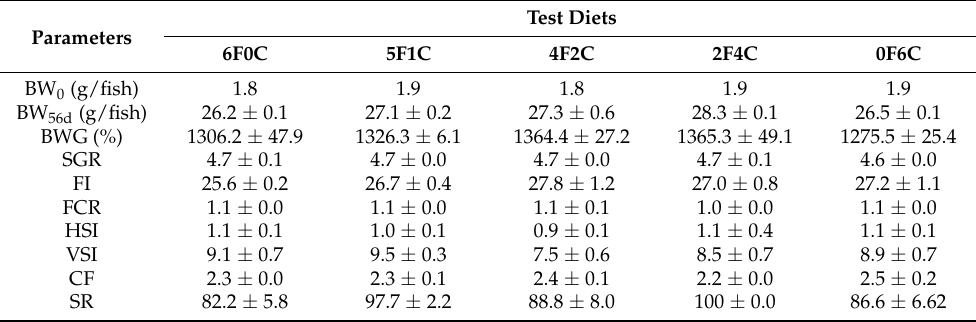
Table 3. Performance variables and biometric indices of red seabream ( Pagrus major ) fed the test diets for 56 days.